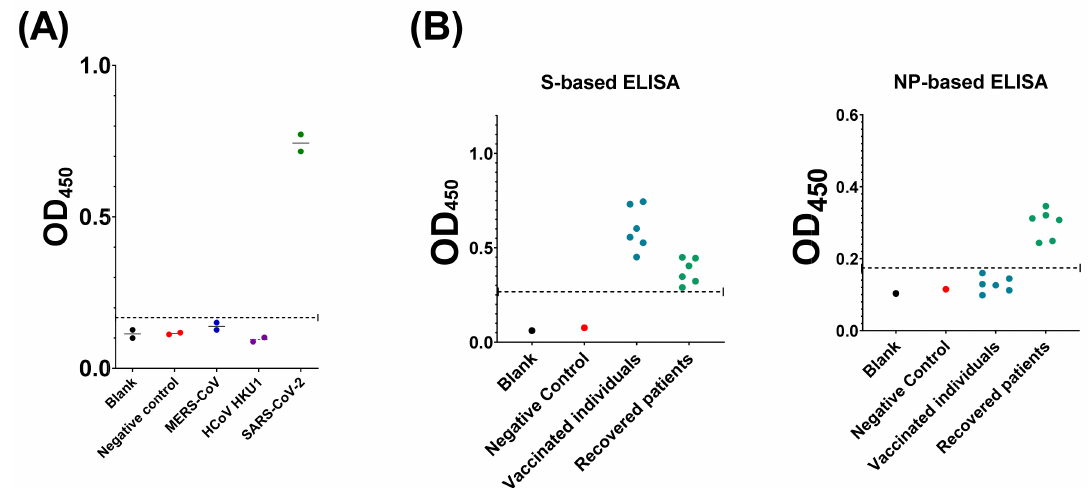
Figure 6. Evaluation of cross-reactivity. ( A ) Human sera containing IgG antibodies to SARS-CoV-2 (green), MERS-CoV (blue), or HCoV-HKU1 (purple) were subjected to the developed COVID-19 NP IgG ELISA. ( B ) Samples obtained for vaccinated people (blue) or recovered patients (green) were tested for the presence of IgG antibodies directed to SARS-CoV-2 S protein (left panel) and NP protein (right panel). Negative control (red) and blank (black) were included in all experiments. Dashed lines represent the assay cut-off